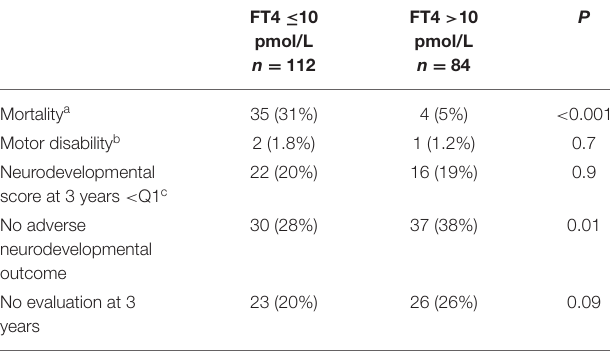
TABLE 4 | Poor outcome at 3 years of age for extremely preterm infants born between 2008 and